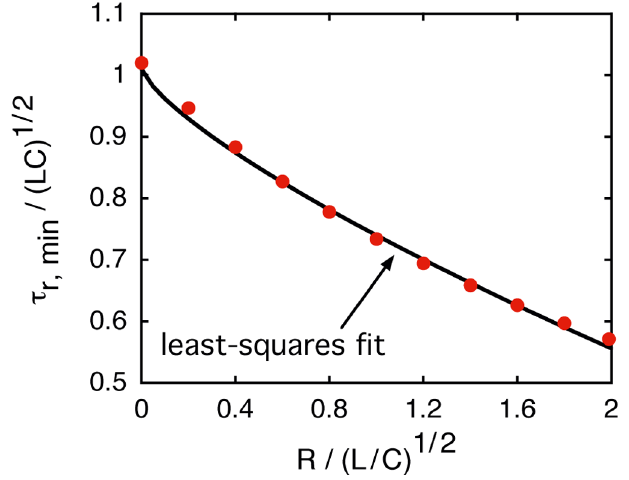
ffiffiffiffiffiffiffiffiffiffi p ffiffiffiffiffiffiffi p LC L=C as a function of R= .